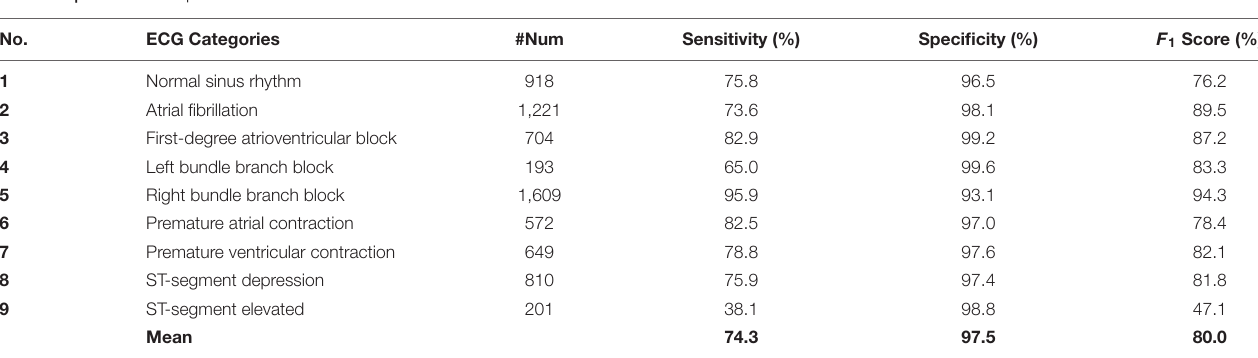
FIGURE 3 | Performance comparison between Method I (evolutionary neural system approach) and the proposed Method II [convolution neural network (CNN)-bidirectional long short-term memory (BiLSTM) approach] in processing Database I. T train , training stage time of the evolutionary neural system and proposed CNN-BiLSTM. Note that the testing time (T test ) of Method I and Method II is less than 10 s, which is not shown in the figure. TABLE 2 | Classification performance of Method II on Database